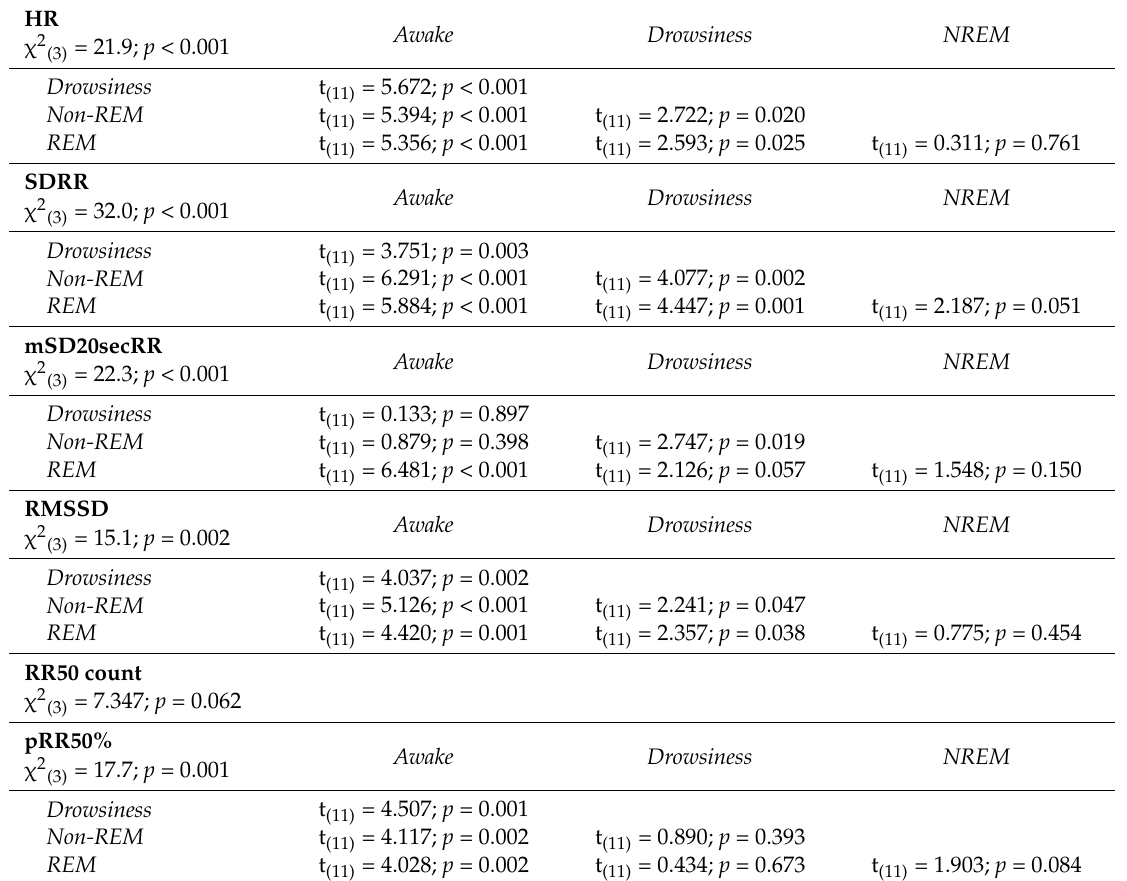
Table 4. Differences between sleep stages using the various ECG parameters calculated based on the first occurrence of the given